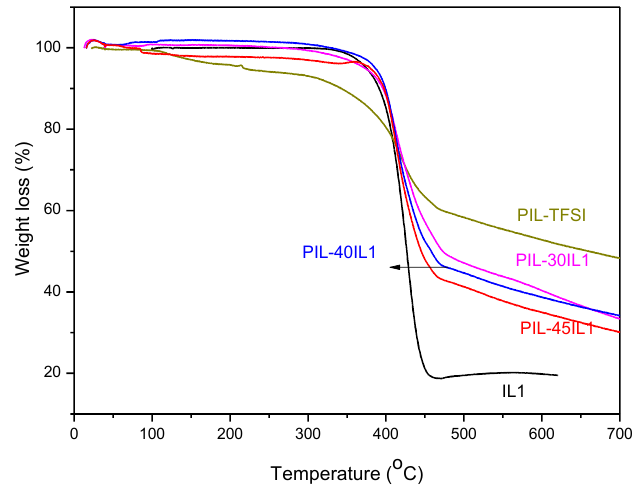
Figure 7. TGA curves of neat PIL and PIL-IL1 composite membranes.